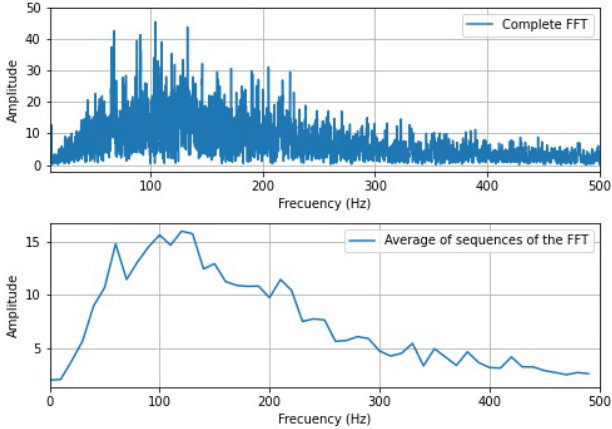
Figure 12. FFT signals used in the